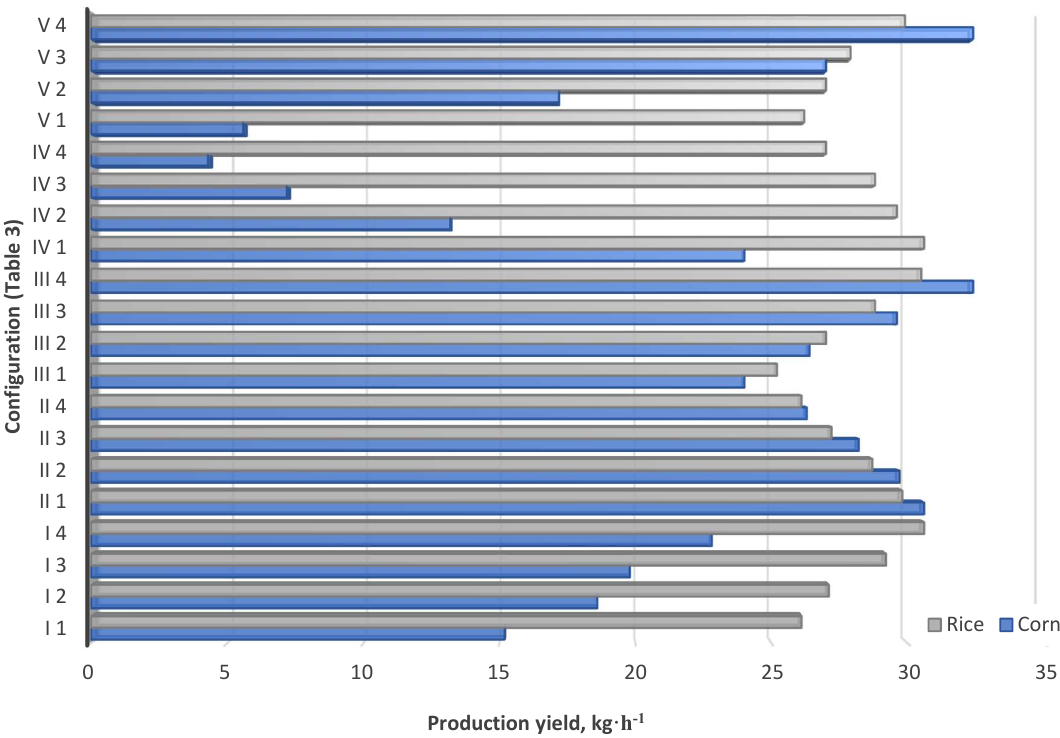
Figure 6. Test results of rice and corn grinding.